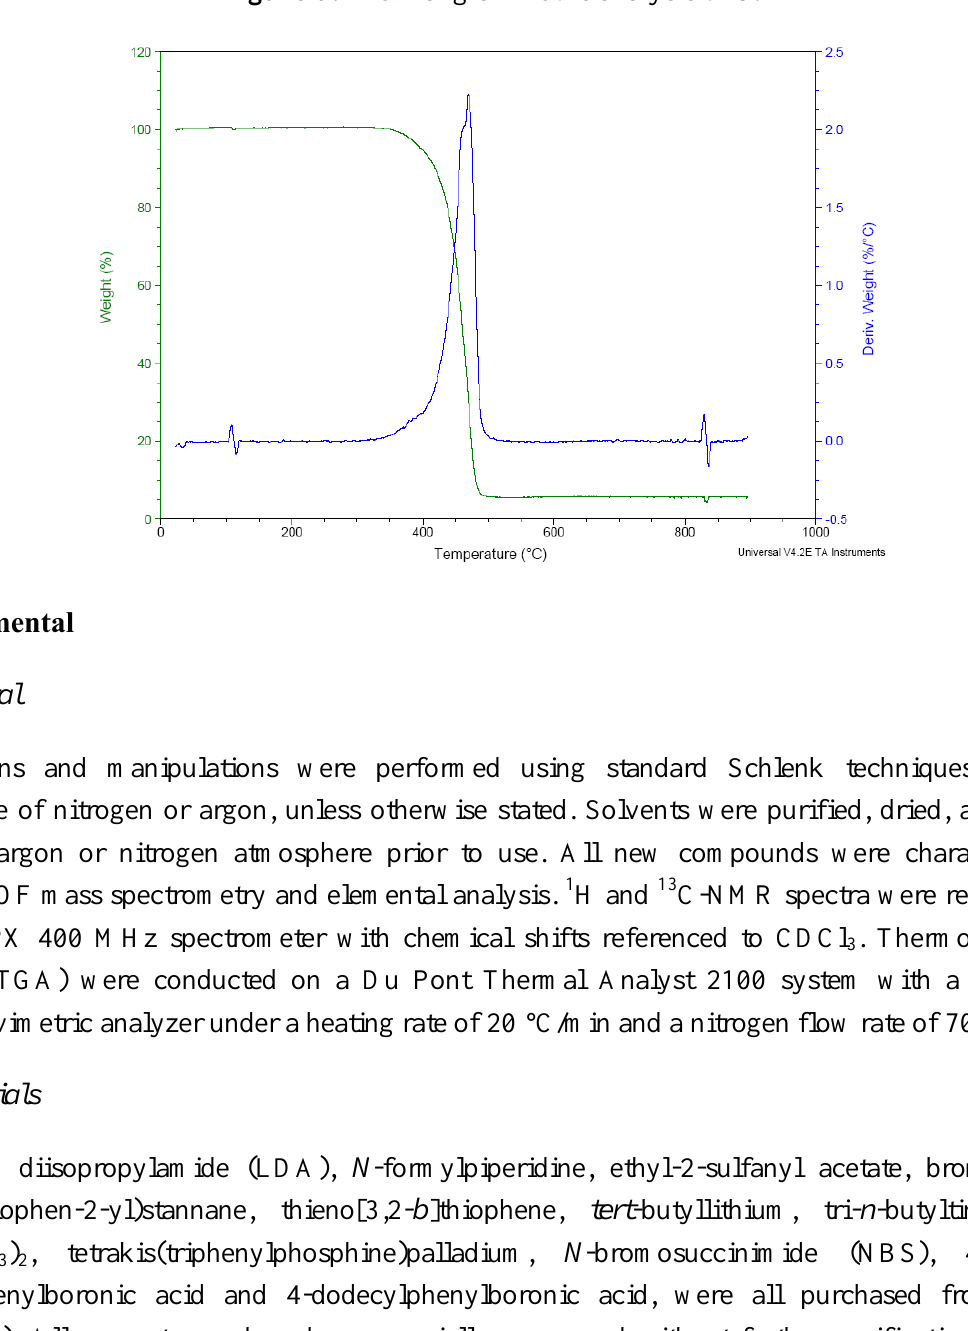
Figure 6. Thermal gravimetric analysis of 5